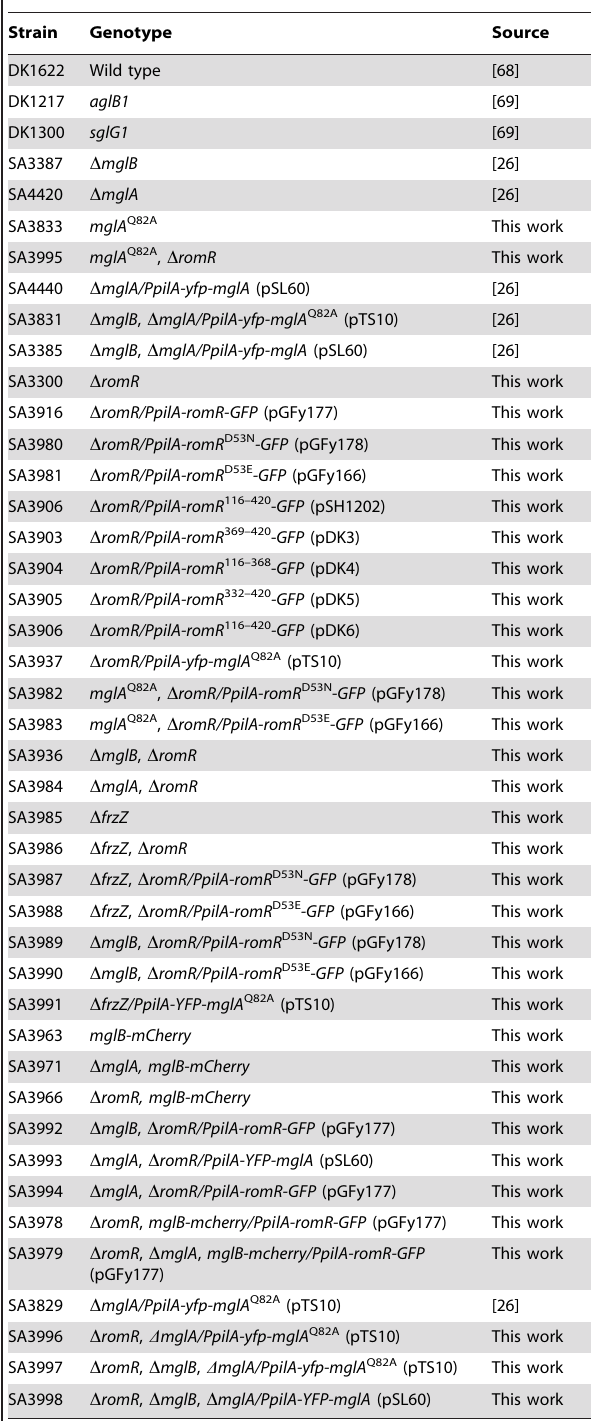
Table 1. M. xanthus strains used in this